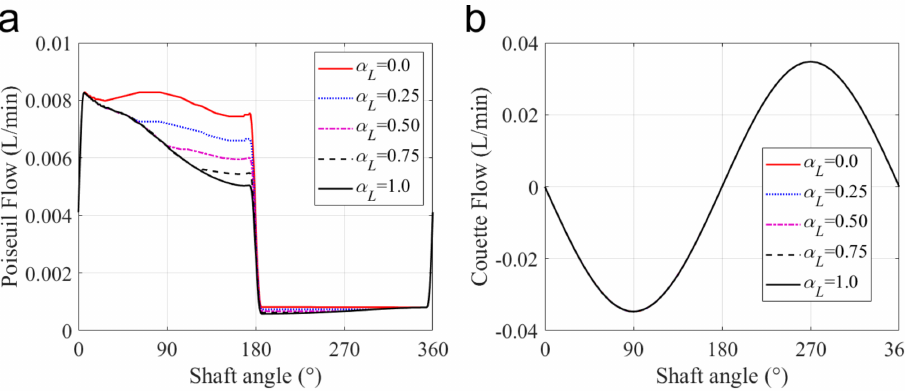
Figure 16. The components of leakage flow with the different cylinder lengths: ( a ) the Poiseuil flow, ( b ) the Couette